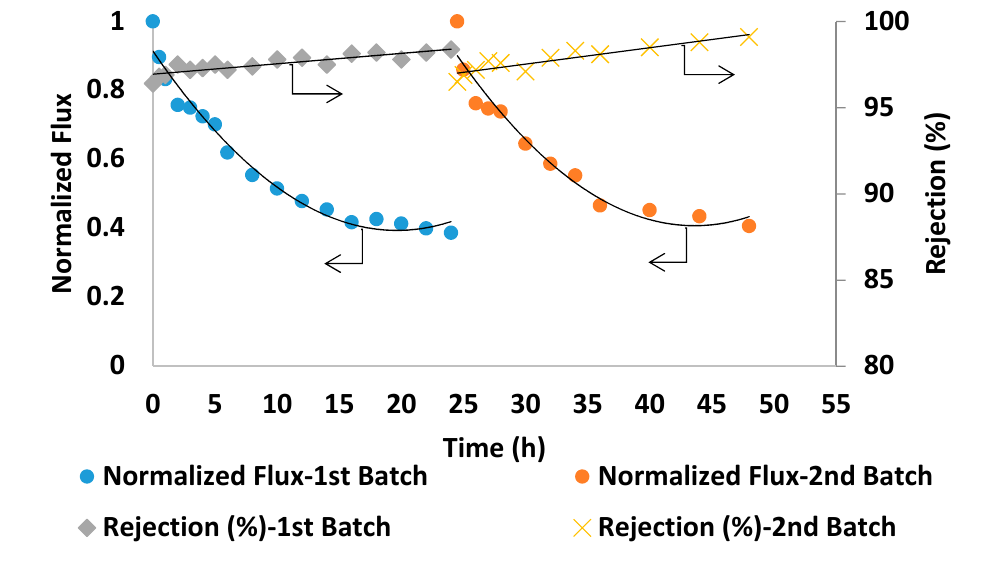
Figure 11. Normalized flux and salt rejection vs time of PA/AG membrane at 0.2 wt.% AG in the dope solution. TDS of the feed solution: 45,000 ppm, pH 8.36. Operating pressure: 54 bars.